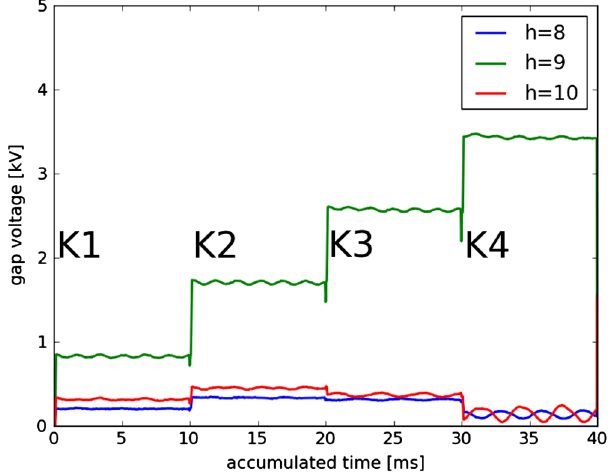
FIG. 4. Harmonic components of the wake